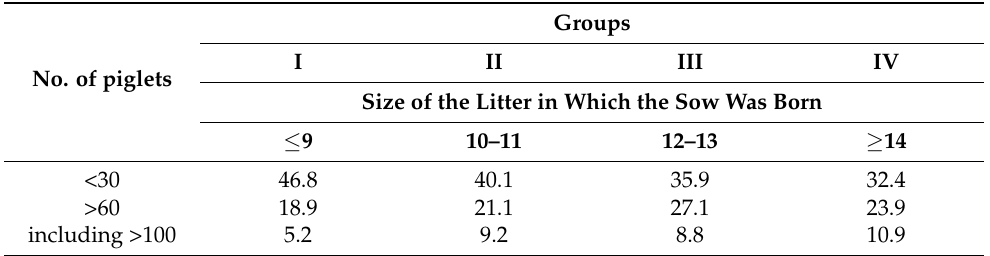
Table 4. Percentage of sows that produced a certain number of piglets during their productive